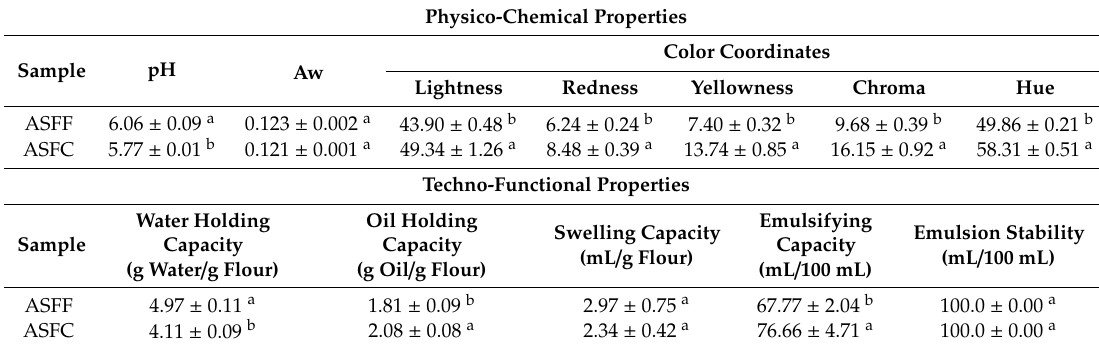
Table 2. Physico-Chemical and Techno-functional properties of almond skin flours obtained from Turr ó n